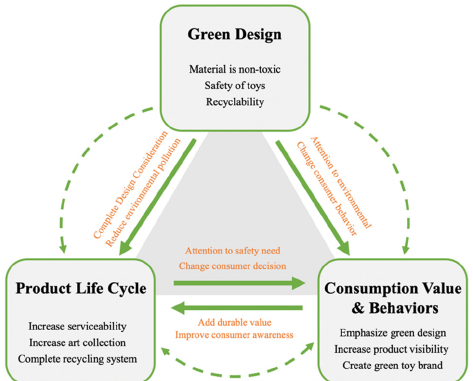
Figure 1. Model for the decision-making factors of green design for kid’s toys (Source: compiled by this research).